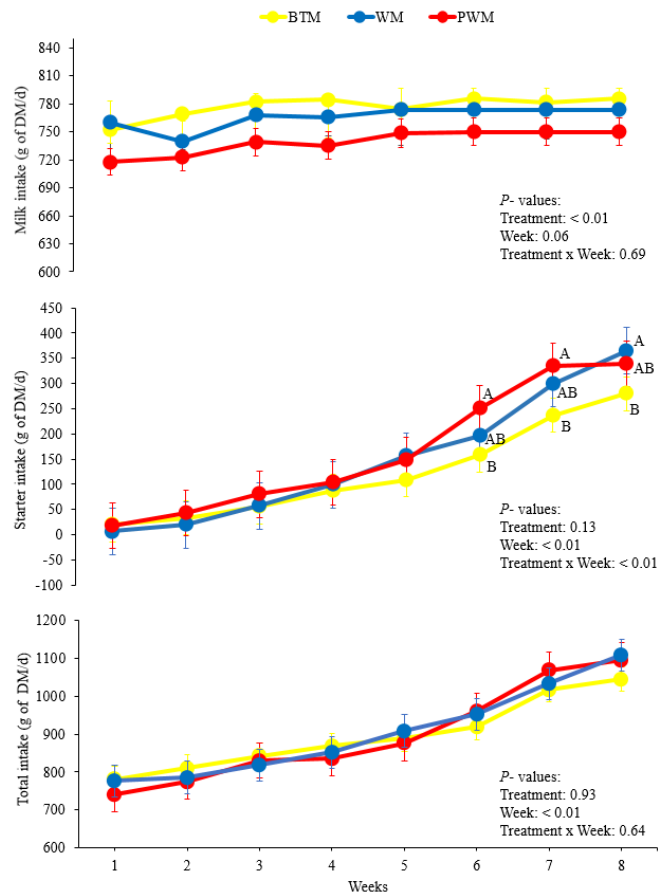
Figure 1. Dry matter intake (milk, starter, and total) of dairy calves fed bulk tank milk (BTM, n = 15), waste milk (WM, n = 15), and pasteurized waste milk (PWM, n = 15) during the period from 4 to 60 d. Bars represent SEM. Letters represent statistical difference between treatments ( p < 0.05). Table 3. Ruminal and blood parameters of dairy calves fed bulk tank milk (BTM, n = 15), waste milk (WM, n = 15), and pasteurized waste milk (PWM, n = 15) during 4–60 d of age.